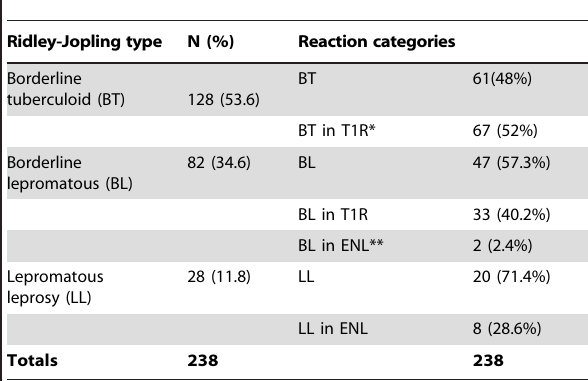
Table 2. Classification of patients by Ridley-Jopling and reaction